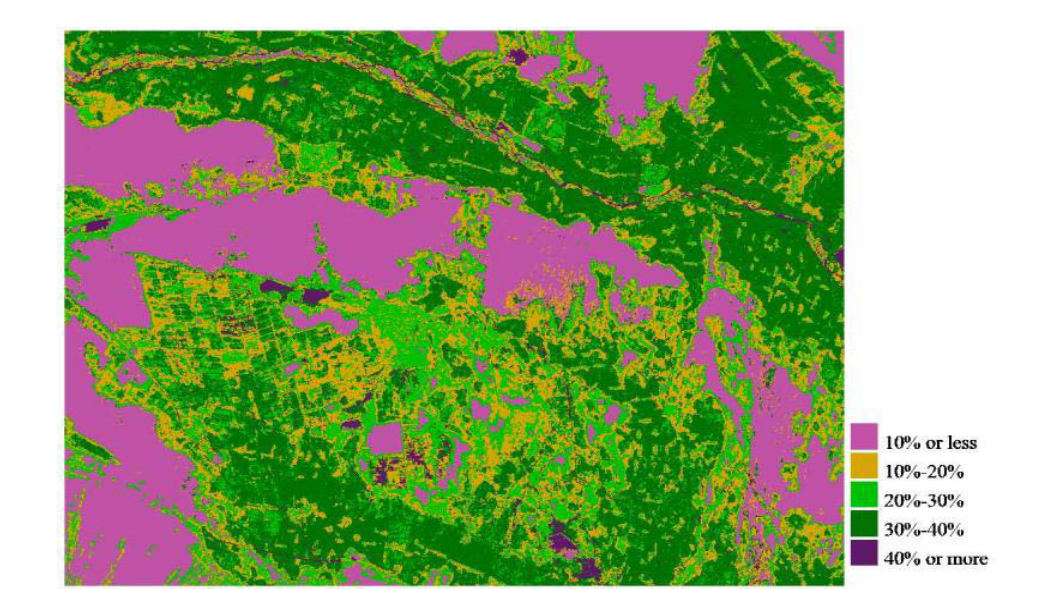
Figure 2. The distribution image of soil moisture in Zhang